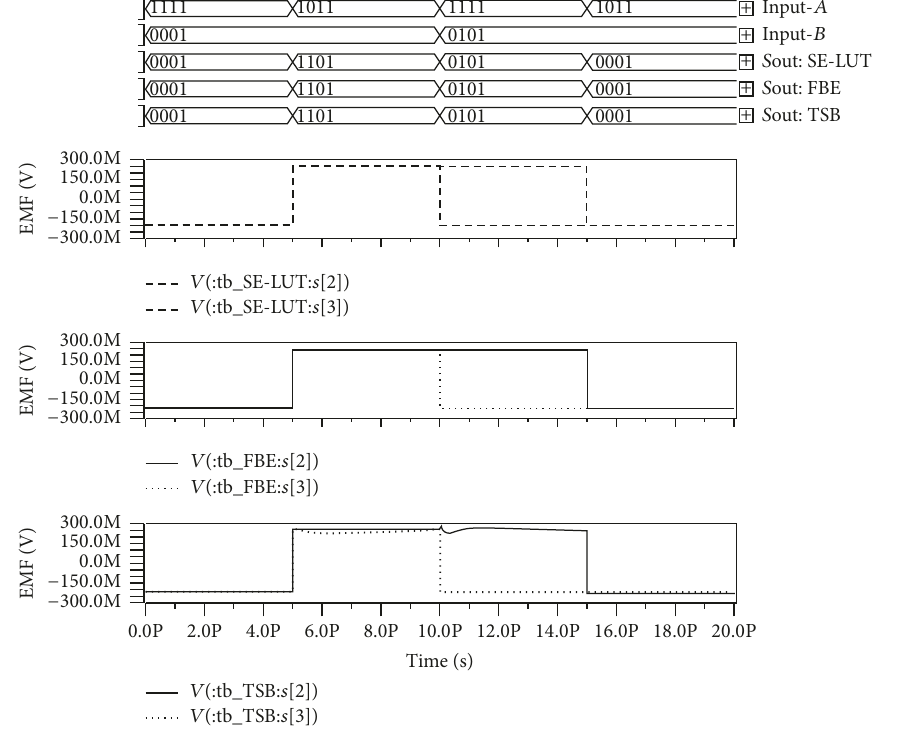
Figure 17: Carry select adder output